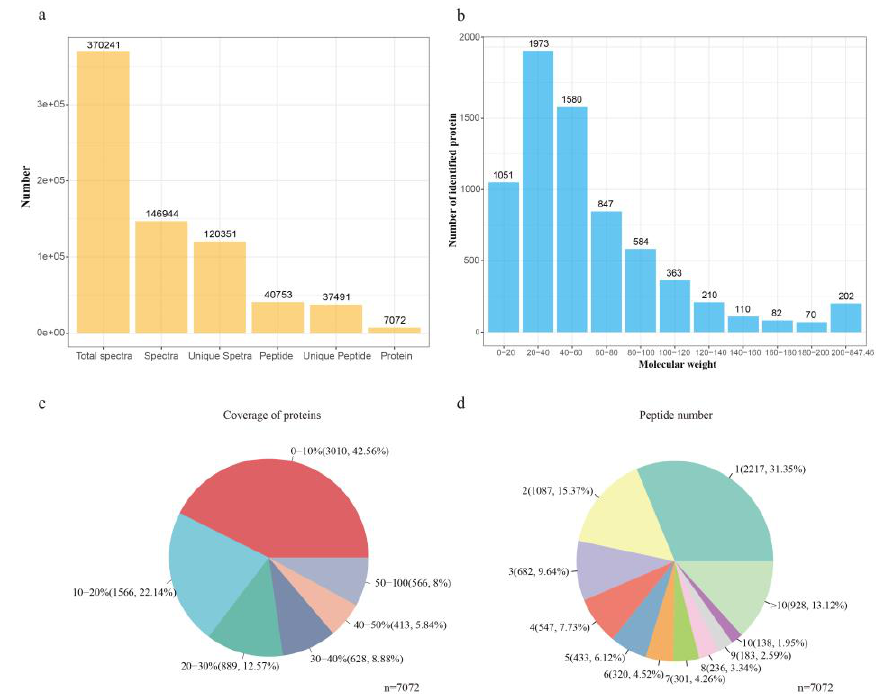
Figure 2. Protein identification and analysis using the isobaric tag for relative and absolute quantification (iTRAQ). ( a ) Overview of protein identification results. ( b ) Classification of identified proteins by molecular weight. ( c ) Coverage of proteins by the identified peptides. ( d ) Distribution of proteins with different peptide numbers.